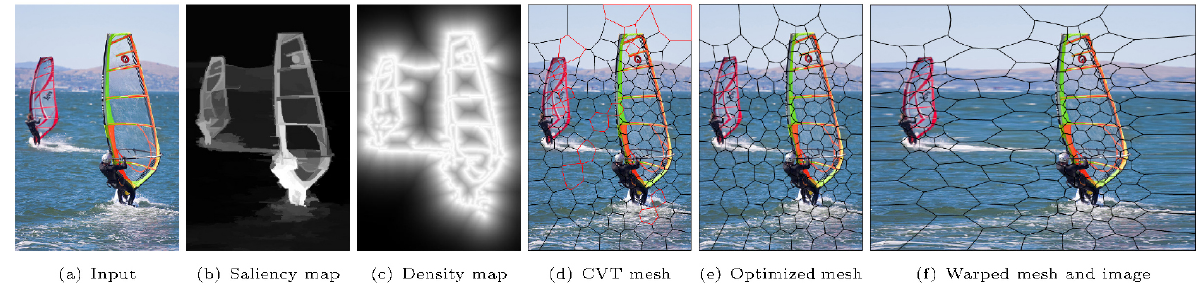
Fig. 4 Pipeline of the proposed algorithm. Given an input image (a), a saliency map is generated from object level semantic information (b). A density function is computed (c), and used to generate a content-aware polygonal mesh (d); cells incident to an edge shorter than 5% of the mean edge length are shown in red. This is optimized to remove short edges (e) and finally the warped mesh is computed by optimizing a distortion energy to give the warped image